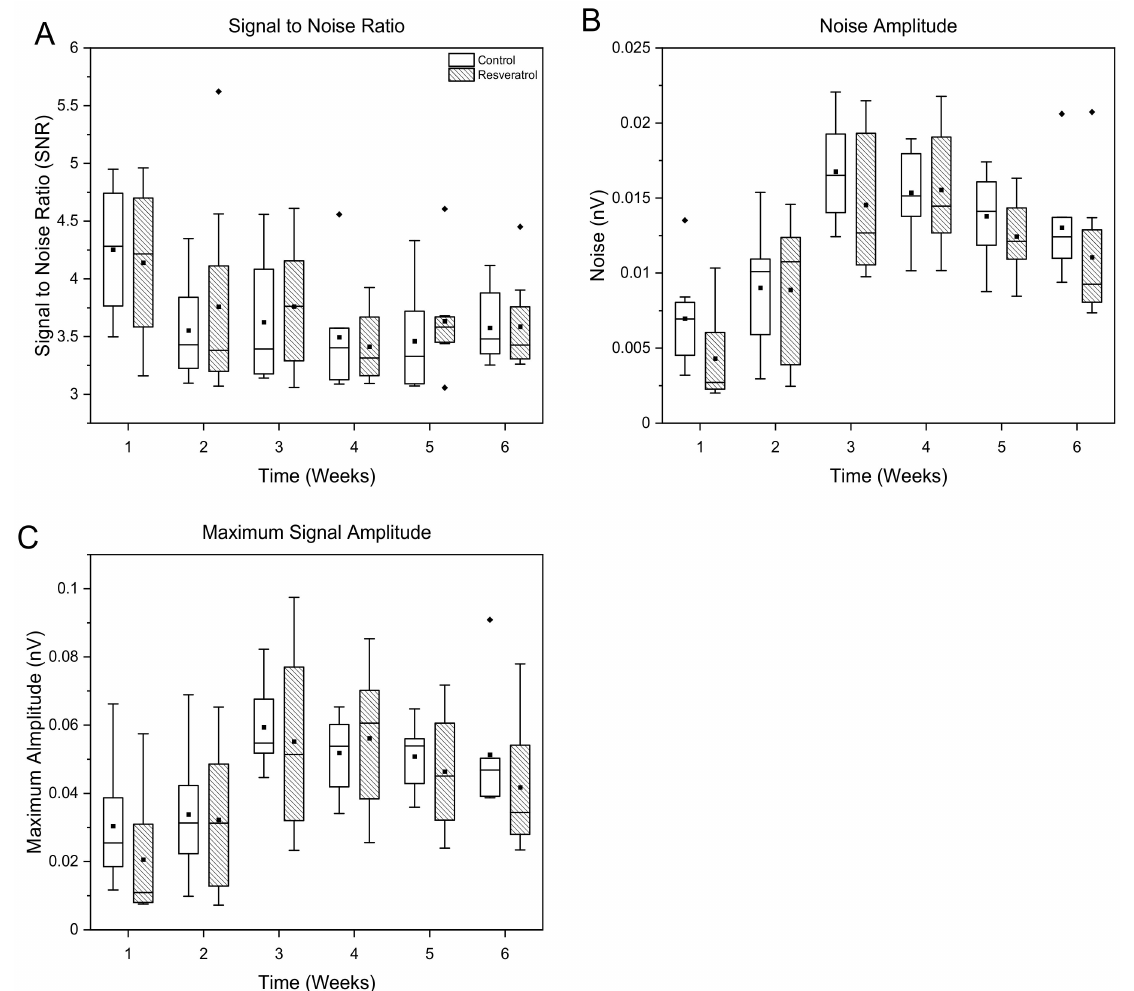
Figure 4. Assessment of recording performance defined as the ( A ) signal to noise ratio, ( B ) noise amplitude, and ( C ) maximum signal amplitude of animals administered resveratrol via intraventricular delivery (dashed box) compared to control animals (white box). No significant differences were seen for the duration of this study, here grouped as acute versus chronic for space and clarity. N = 8 animals per group. The whiskers represent the range within 1.5 IQR, the lines inside the boxes represent the median line, the solid squares in the middle represent the mean and the diamonds represent